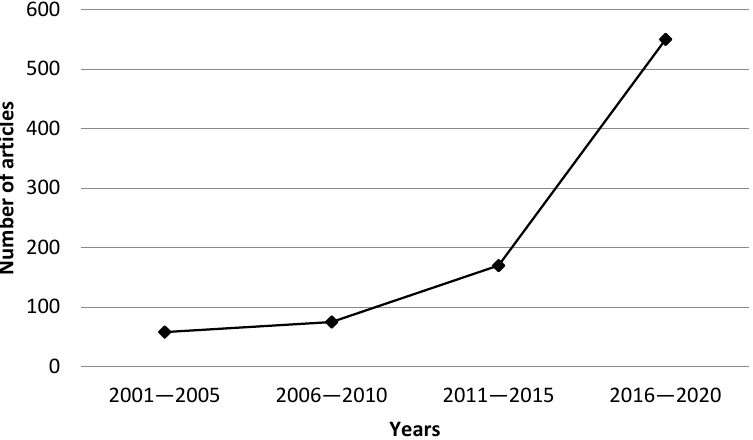
Figure 2. Number of publications grouped in periods of five years between 2001 and 2020.